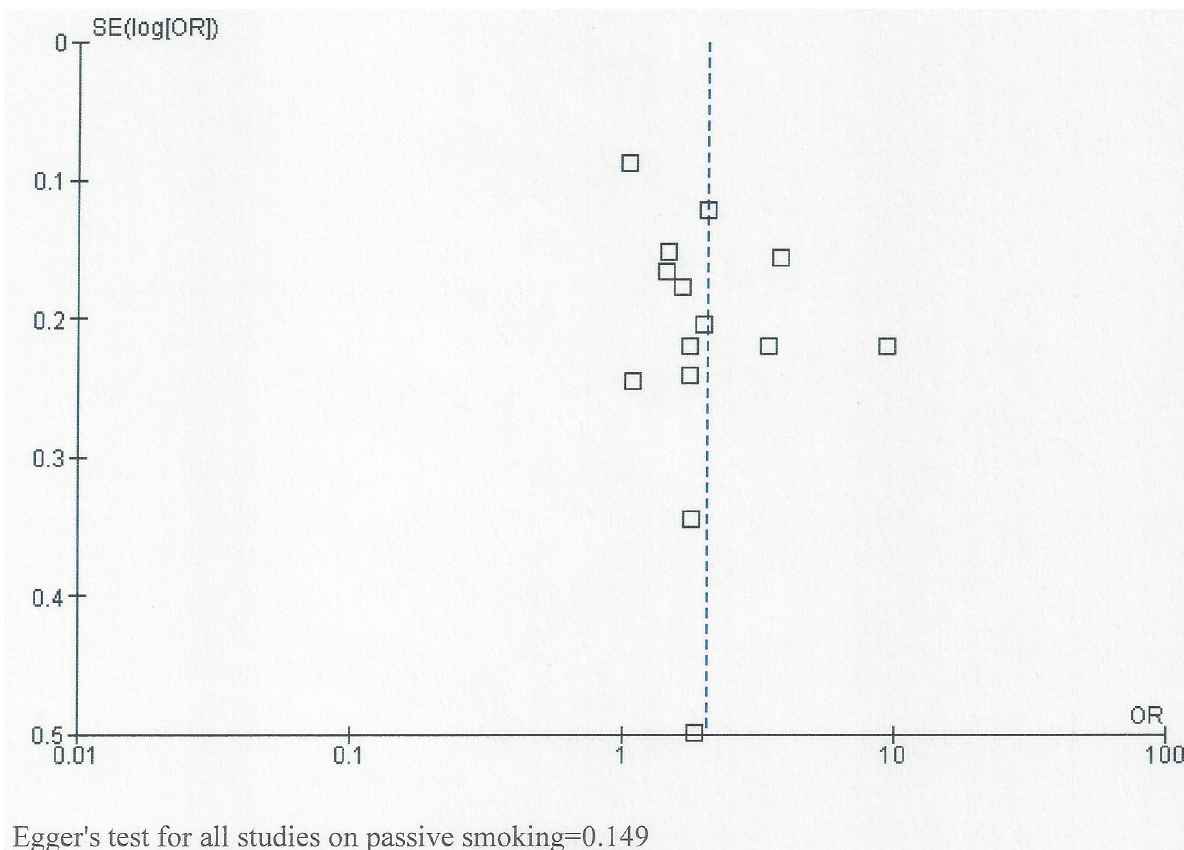
Fig 8. Forest plot for meta-analysis of the association between maternal passive smoking and NSOFC according to study quality (NOS scale).